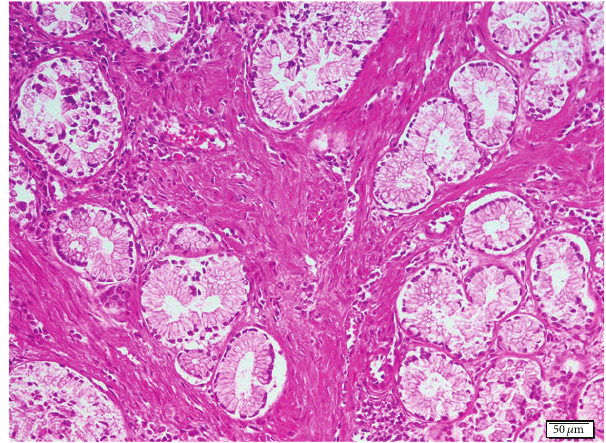
Figure 3: High power photomicrograph of a section of the polypoid mass showing several bands of well-differentiated smooth muscle cells between gastric antral-type glands lined by tall columnar mucinous epithelium. HE stain. Bar = 50 𝜇 m.